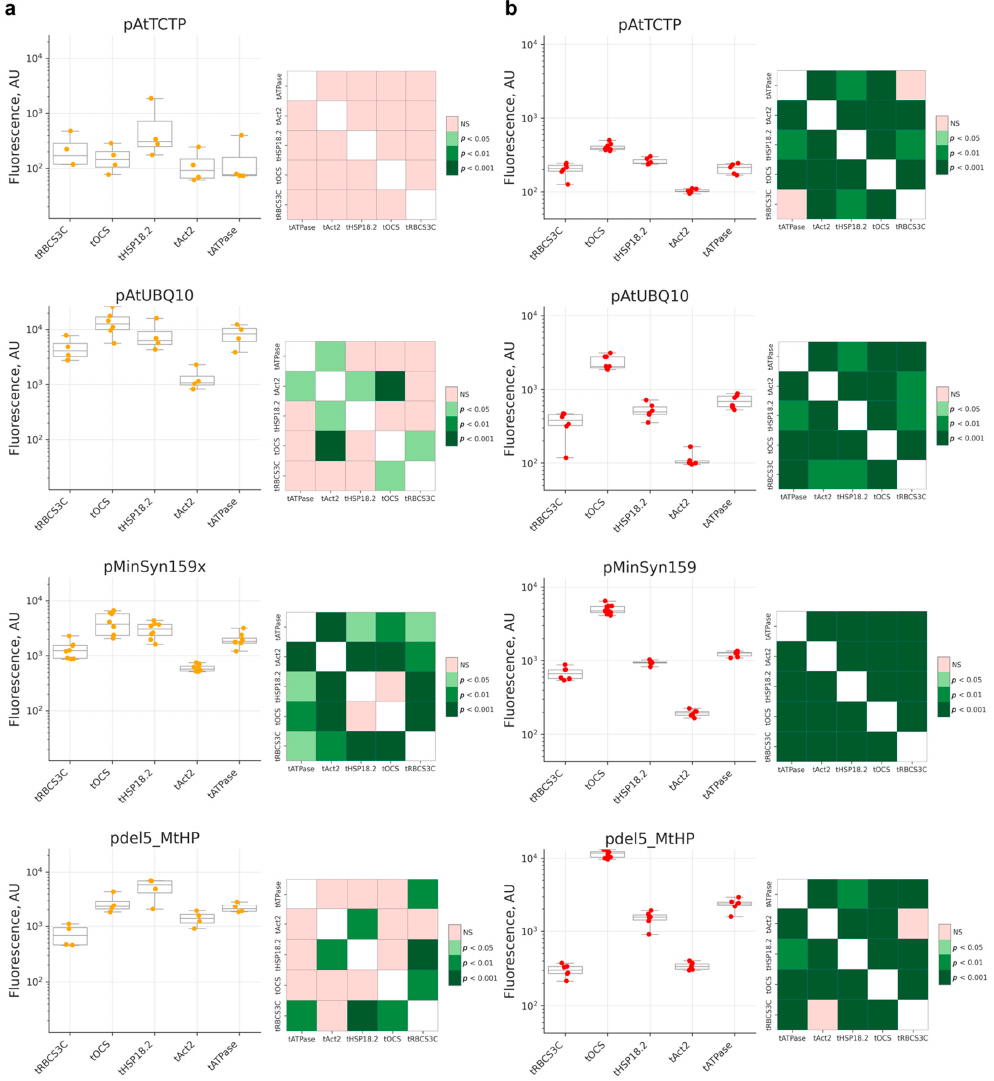
Figure 4. Comparison of terminators in the context of different promoters in two expression systems: ( a ) N. benthamiana leaf agroinfiltration ( N = 4 leaves for each promoter) and ( b ) N. tabacum BY-2 plant cell packs ( N = 6 cell packs for each promoter). Box and whisker plots ( left ) on each panel are accompanied by color-coded p -values of Conover’s test ( right ). NS—non-significant. The box extends from the lower to upper quartile values of the data, with the horizontal line representing the median. Whiskers represent a full data